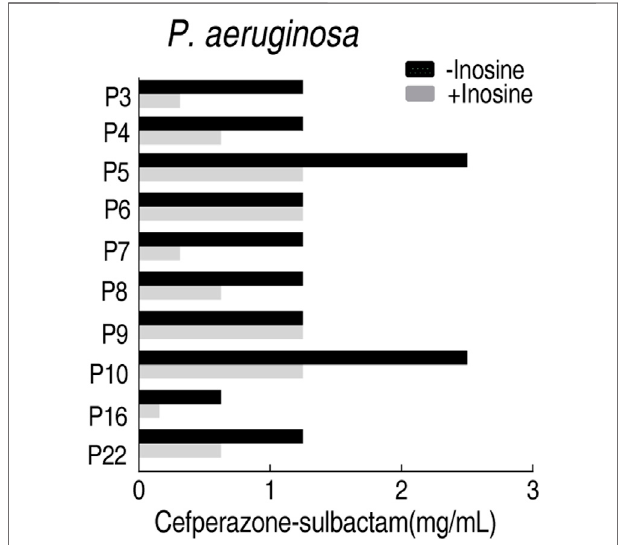
Frontiers in Molecular Biosciences |